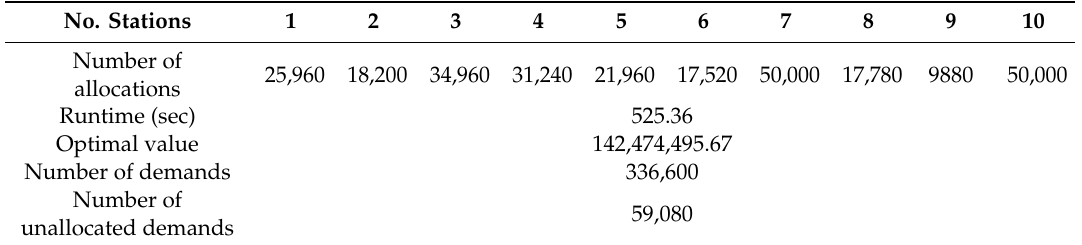
Figure 9. The allocation of each station using the Tabu Search algorithm in the VAOCMP model. Table 14. The number of allocations for each station, runtime, and the optimal value of the function using the Tabu Search algorithm in the VAOCMP model.